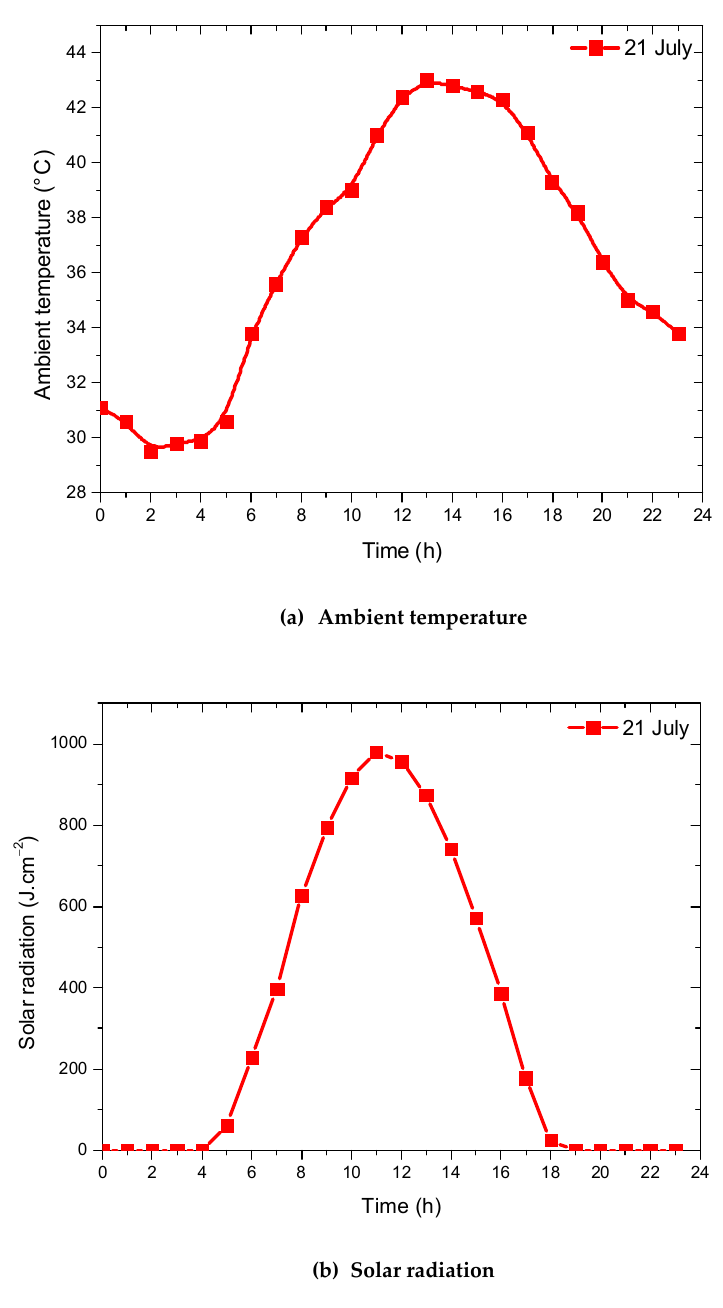
Figure 4. Environmental conditions on 21 July (Ghardaïa site). Table 4. Solar AGMD system operating conditions obtained from thermodynamic analysis (maximum